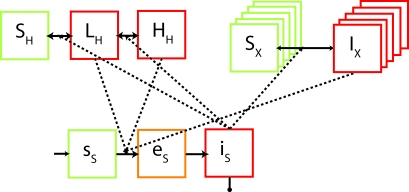
Structure of the Dynamic ModelSubscripts denote species (H, human; S, snail; X, one of dog, cat, water buffalo, pig, or rat). Infection states are E, exposed and infected but not yet infectious; H, heavily infected; I, infected; L, lightly infected; and S, susceptible. Solid lines show the natural history of infection assumed for each species and dashed lines show the contribution by one species to the force-of-infection of another. The line below IS, terminated by a small circle, indicates the death of infected snails. We assume that the birth rate of susceptible snails is equal to the death rate of infected snails to ensure a constant snail population size.